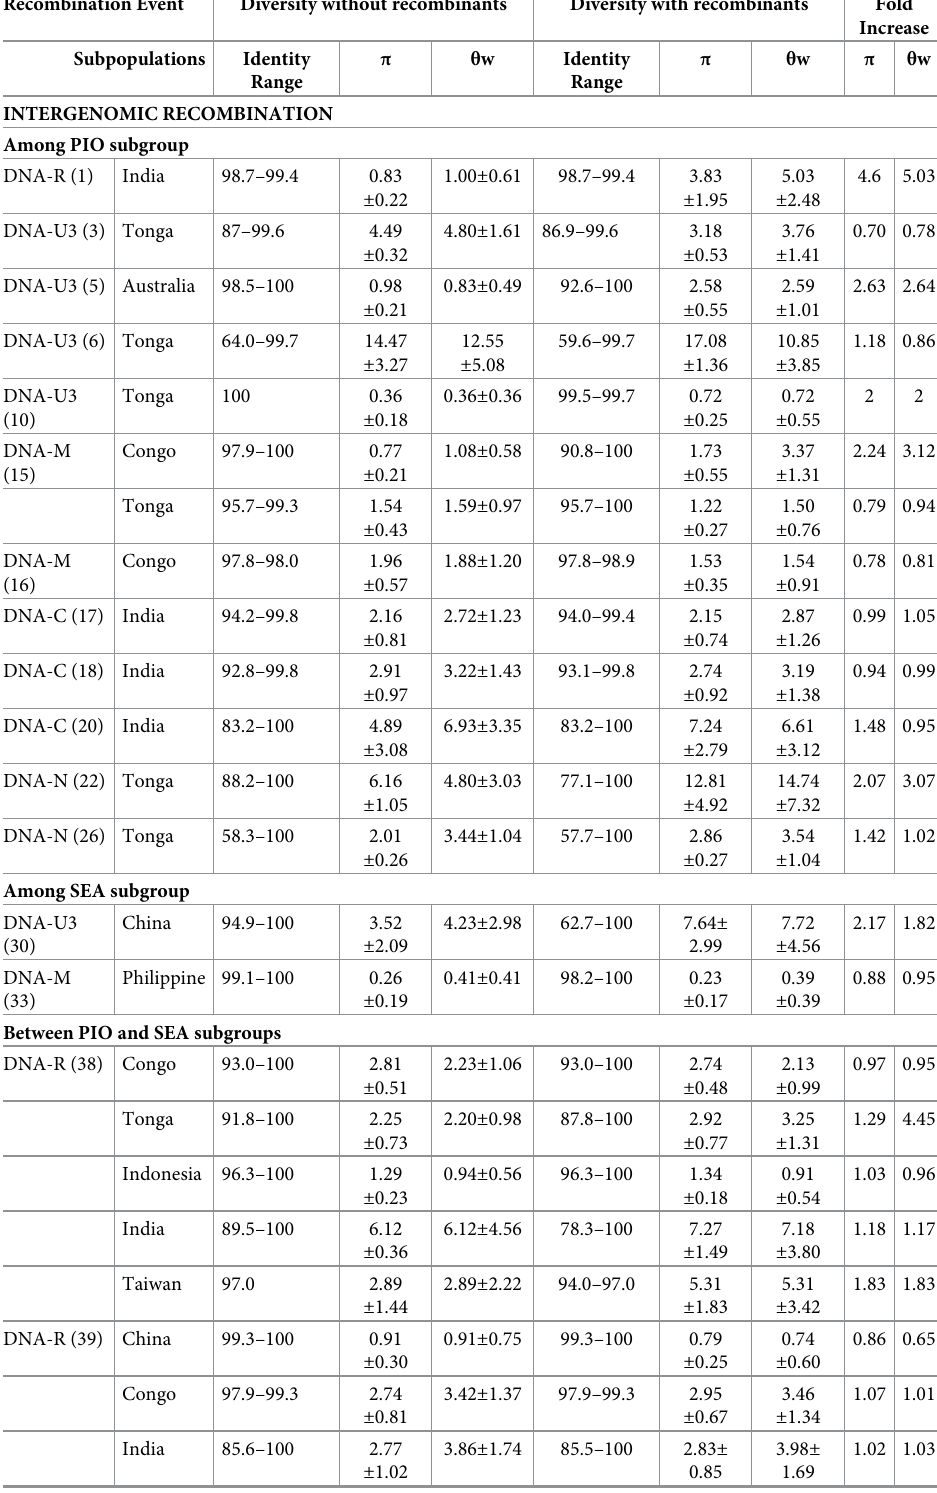
Table 8. Contribution of genetic diversity by recombinant isolates in their